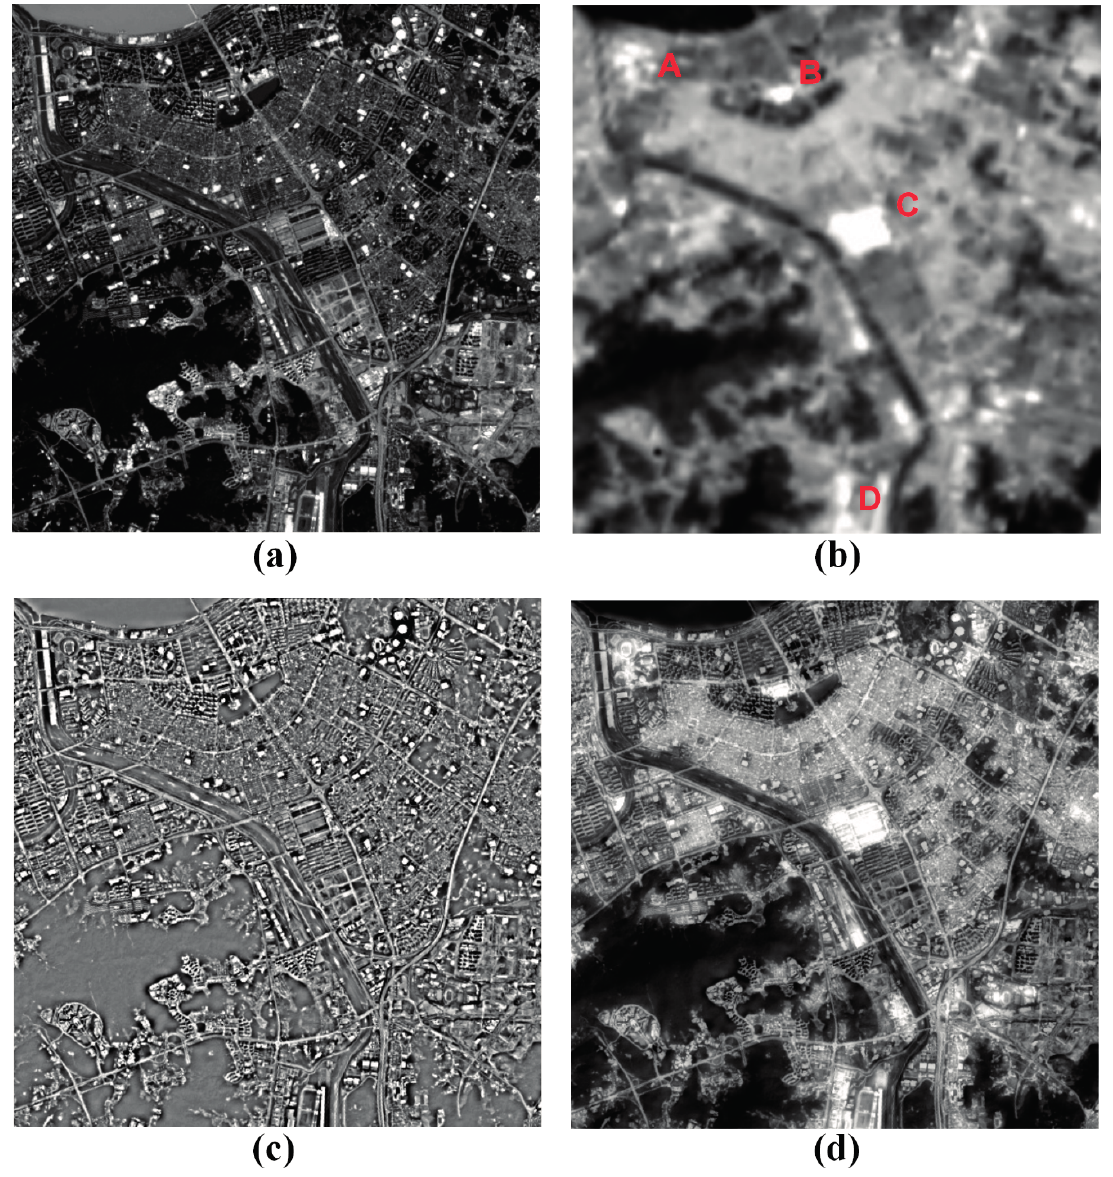
Figure 8. Fused result of the PAN and TIR images obtained from urban areas: ( a ) the PAN and ( b ) TIR images; ( c ) the HP PAN image and ( d ) the fused